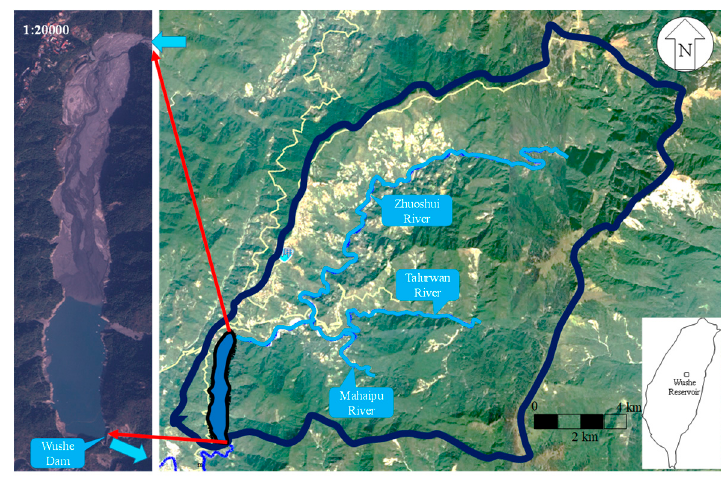
Figure 1. Relative position of Wushe Reservoir.